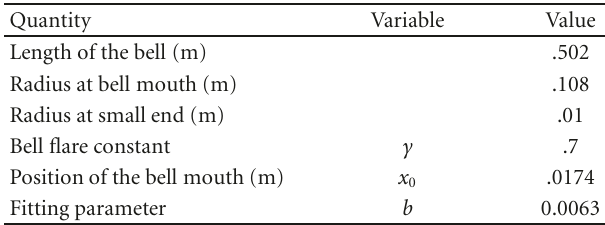
Table 1: Parameters for Bessel horn described by (21) best fitting the trombone